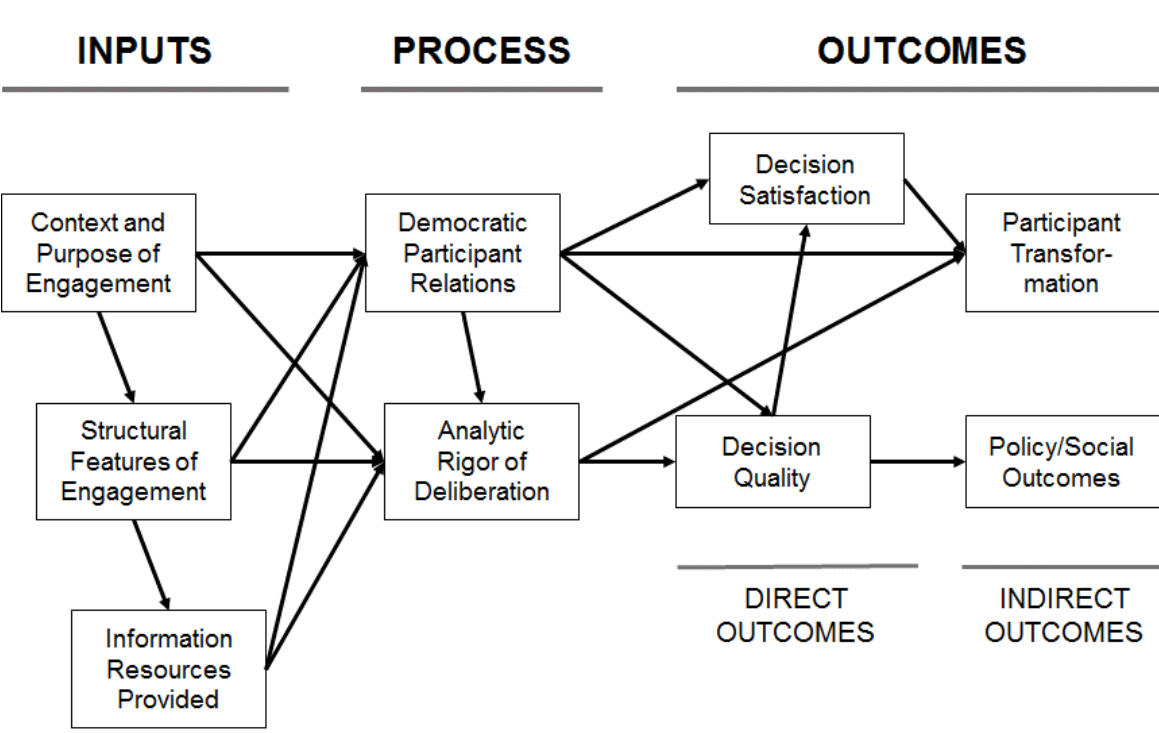
Figure 1. An input-process-outcome model of democratic deliberative civic